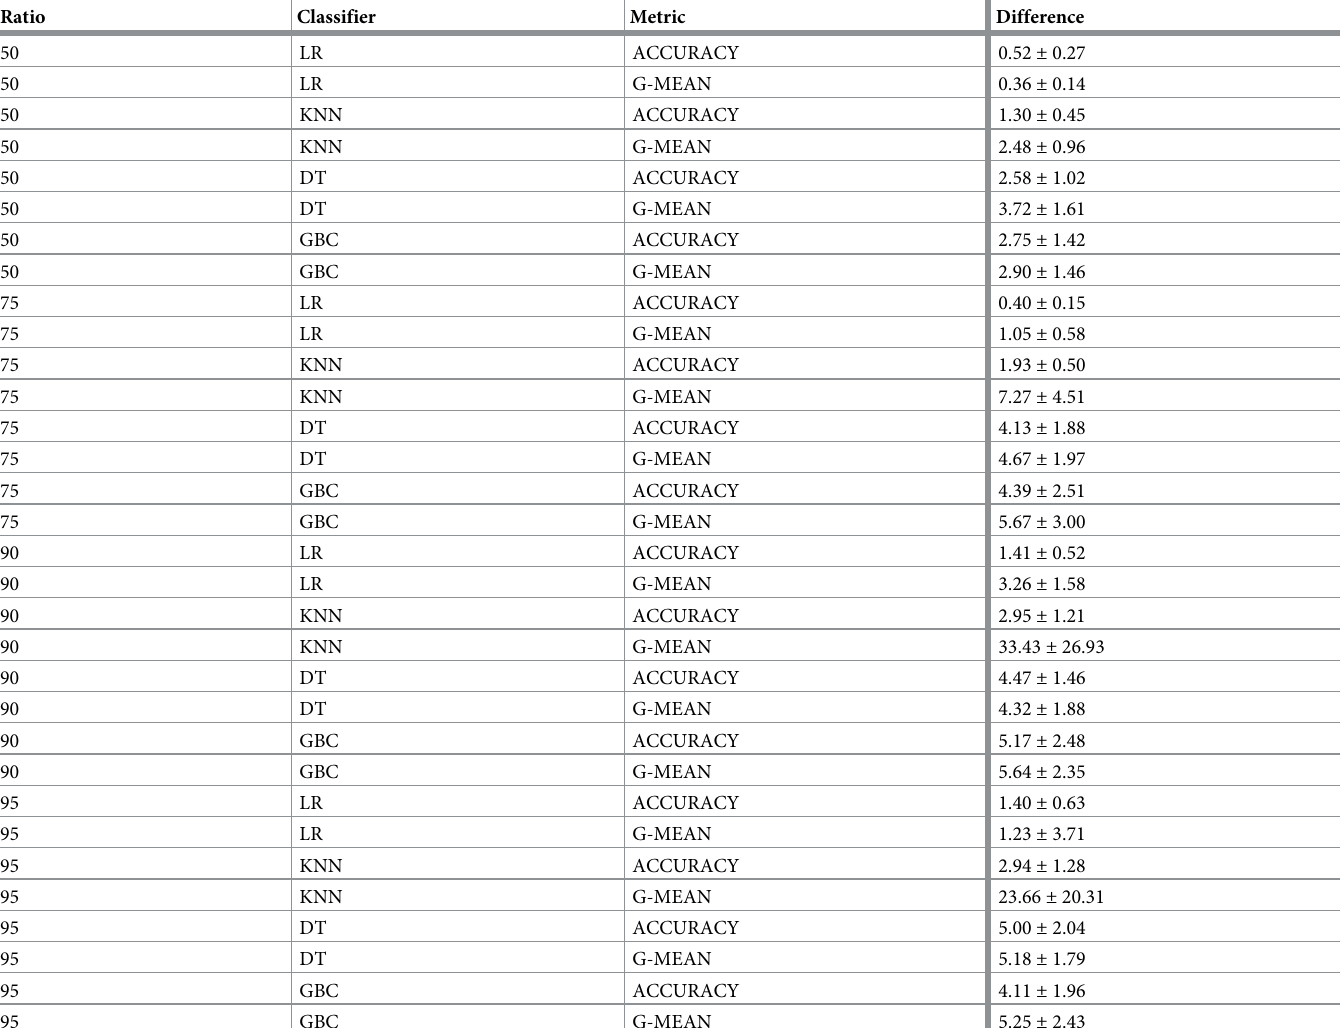
Table 3. Results for percentage difference between GSDOT and